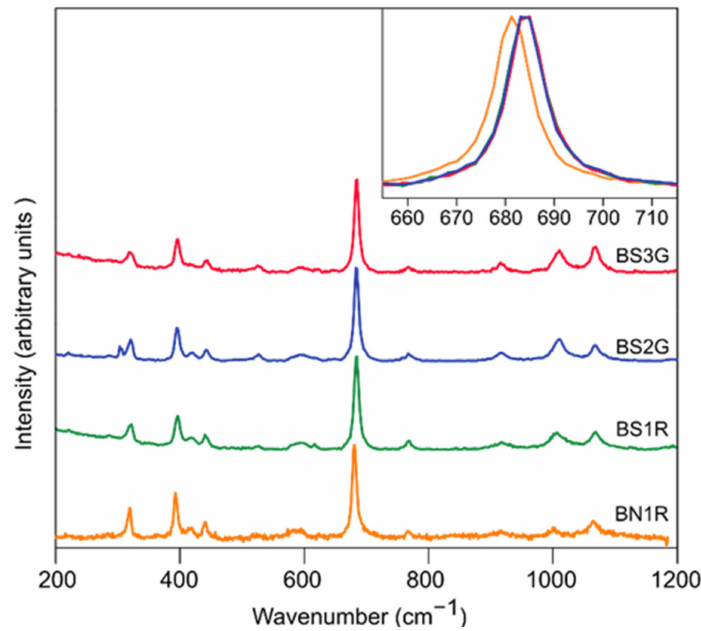
Figure 4. Raman spectra, collected in the range 200–1200 cm − 1 , of the natural and synthetic red beryls of this study. Inset: shift of the mode at ca. 681 cm − 1 in response to the different substituents at the octahedral site, in natural and synthetic samples (see text for details).